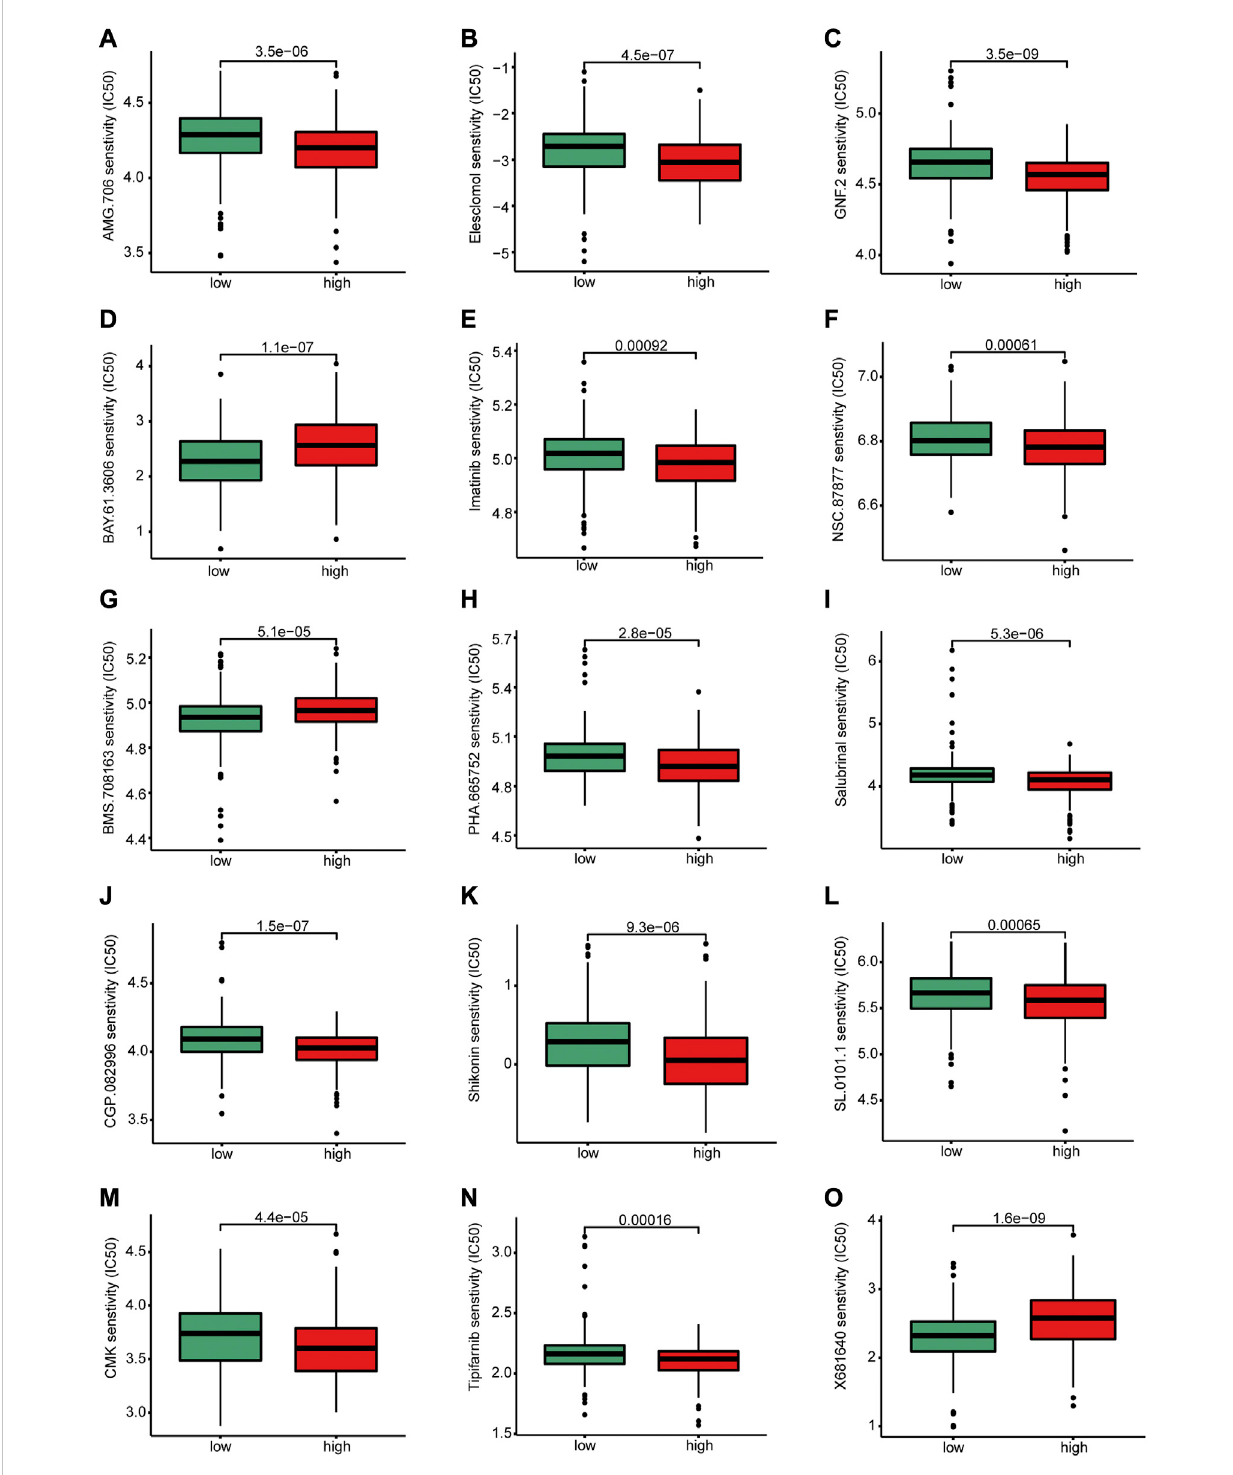
Shikonin, (L) SL.0101.1, (M) CMK, (N) Tipifarnib and (O)